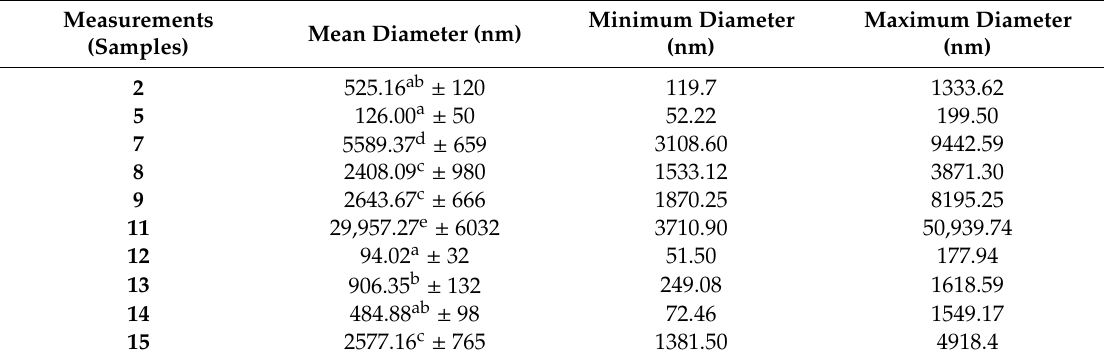
Table 2. Diameter values (Mean ± SD) (nm) from the resulting materials produced in samples 2, 5, 7, 8, 9, 11, 12, 13, 14, and 15 conditions of experimental design